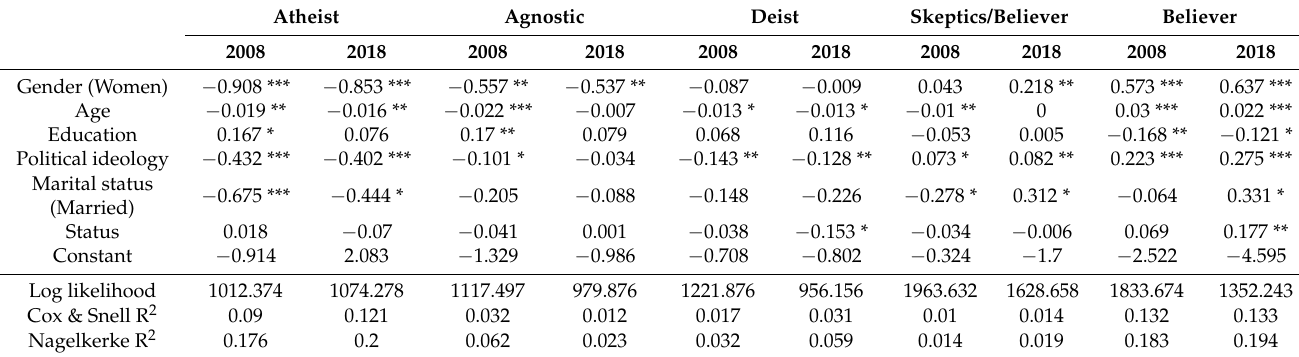
Table 4. Determinants according to logistic regression analysis for each belief